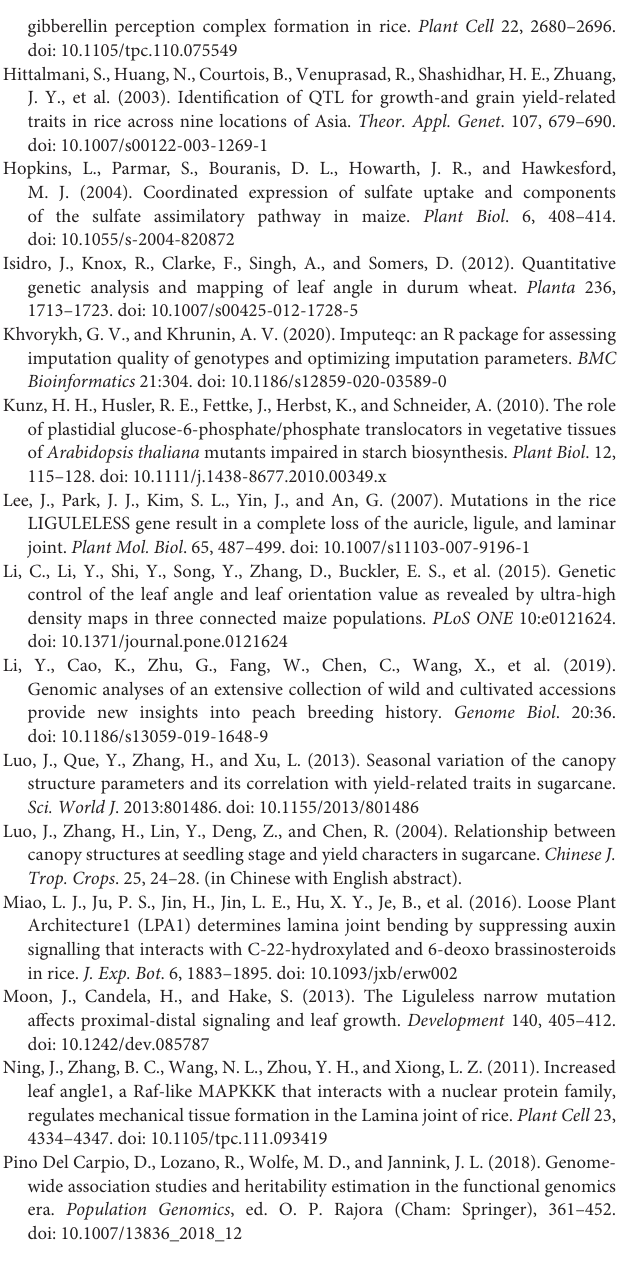
Supplementary Table 1 | Leaf angle and corresponding genotypes of sugarcane natural population at different stages. Supplementary Table 2 | Primer sets used in the PCR